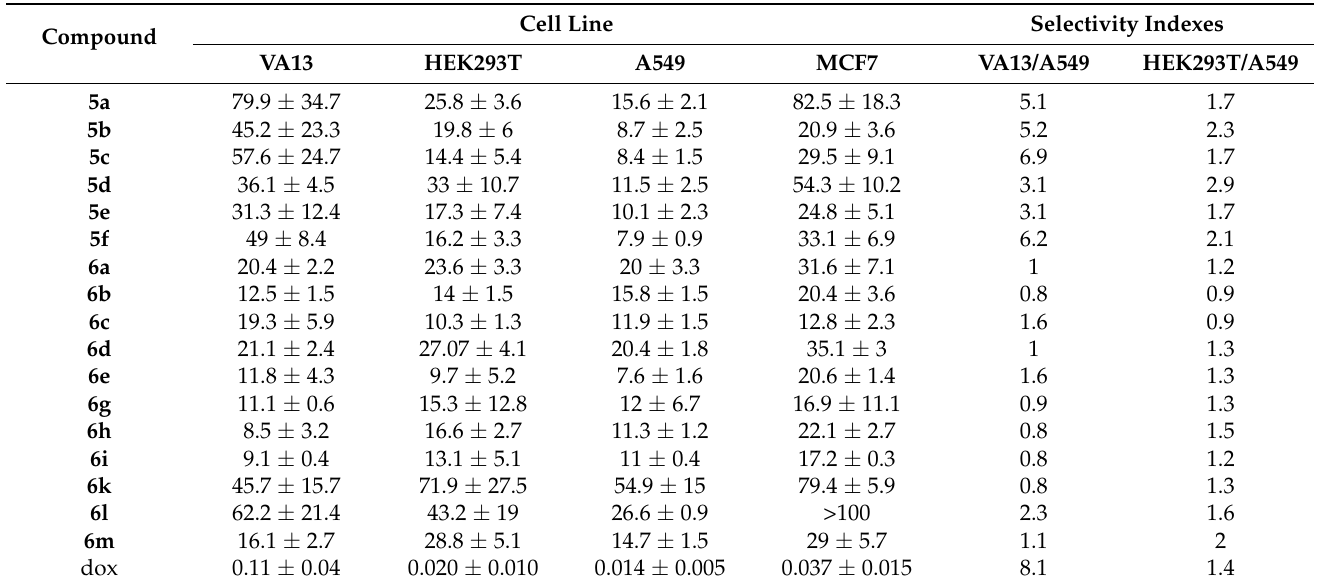
Table 1. Cytotoxicity, µ M (CC 50 value—concentration of compounds that caused 50% death of cells), of some synthesized compounds 5 and 6 against different cell lines after 72 h of treatment, evaluated with the 3-(4,5-dimethylthiazol-2-yl)2,5- diphenyl tetrazolium bromide (MTT) test [42].